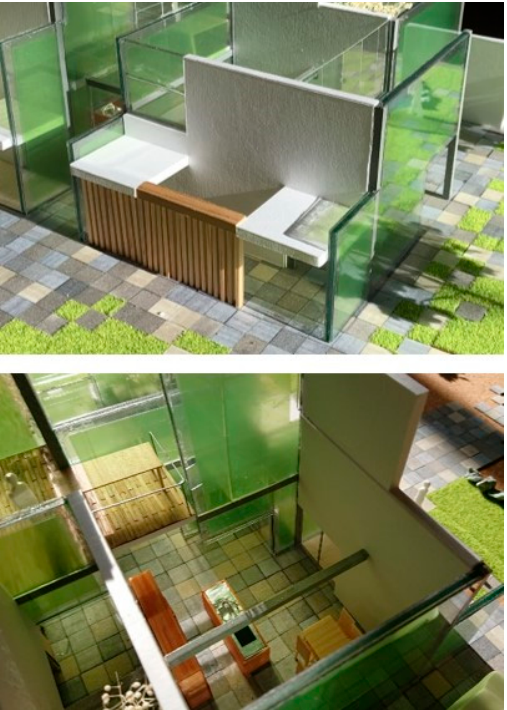
Figure 13. Architectural model with photosynthetic panels applied to the walls.